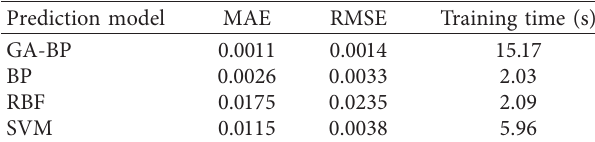
Figure 7: Prediction error of different models on System II. Table 5: The performance of different models.